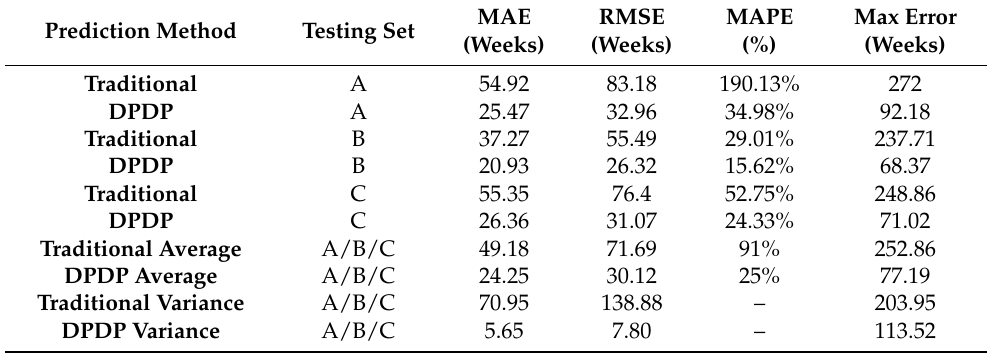
Table 3. Comparing Organization 1’s traditional vs. DPDP prediction accuracy.